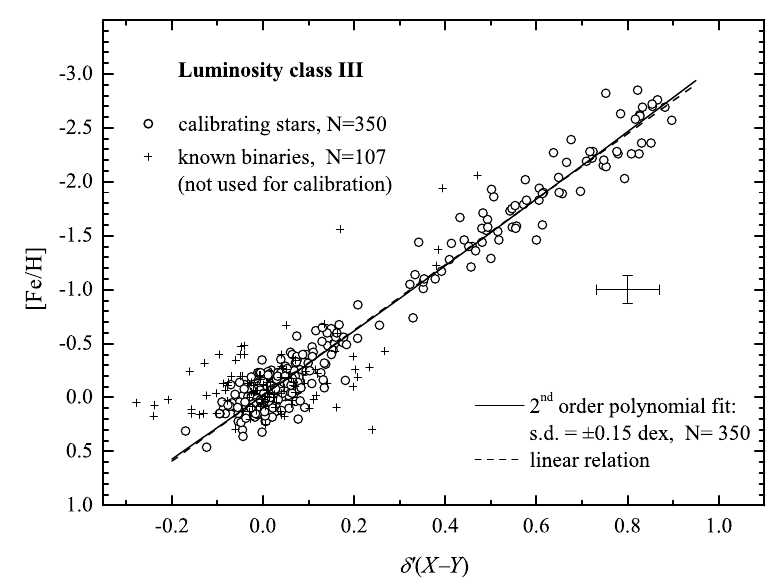
Fig. 7c. (cid:14) ′ ( X – Y ) vs. [Fe/H] relation for giant stars with metallicities from high- dispersion spectroscopy. in general closely the same as in the calibration for dwarf stars. The new calibration for giants is valid in the spectral-type range (cid:24) A8 to M4 ( Y – V = 0.30–1.30, or Y – S = 0.60–2.60) and the metallicity range (cid:0) 2 : 8 (cid:20) [Fe/H] (cid:20) +0 : 5. The accuracy of the calibration and a comparison with BS83 will be discussed in the next subsection. Table 1. Polynomial coefficients of the empirical relations